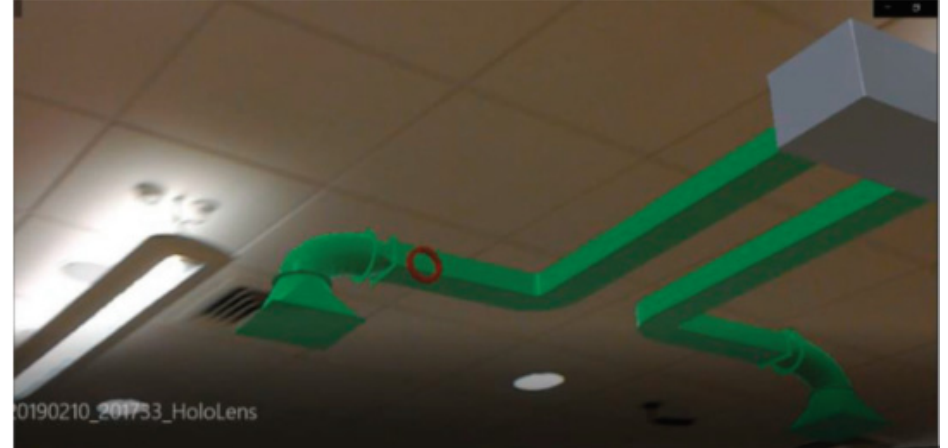
Figure 9. X-ray vision to display the 3D representation of an HVAC (heating, ventilation and air- conditioning) system hidden in the ceiling [43]. air-conditioning) system hidden in the ceiling